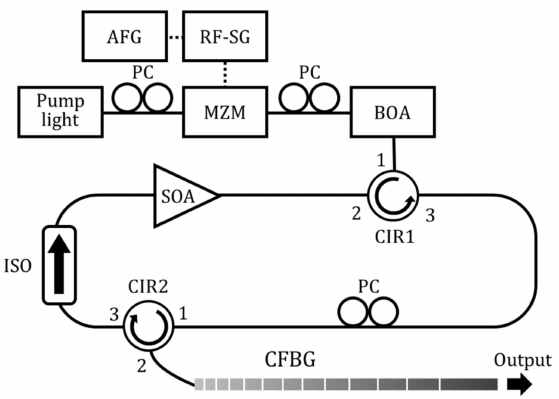
Figure 2. Experimental setup of the wavelength-swept active mode locking (AML) laser based on XGM. BOA: booster optical amplifier; ISO: optical isolator; CFBG: chirped fiber Bragg grating; PC: polarization controller; AFG: arbitrary function